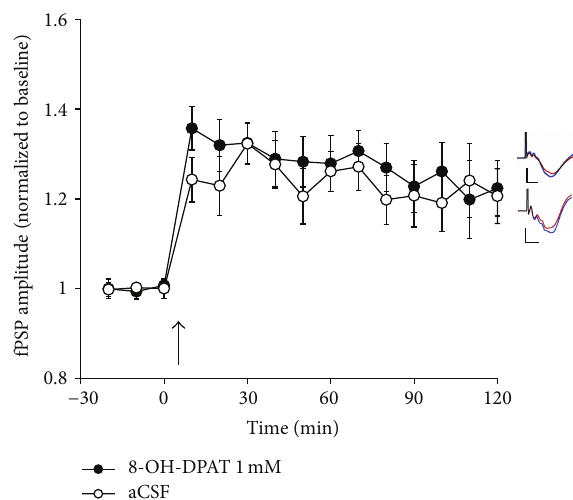
Figure 7: The effect of application (in V1 by means of reverse microdialysis) of either aCSF ( 𝑛 = 7 ) or WAY 100635 (1mM, 𝑛 = 8 ) on LTP following TBS (at arrow) of the LGN in juvenile (mean age 45 days, range 42–48 days), urethane-anesthetized rats. Application of WAY 100635 resulted in a suppression of LTP relative to animals receiving aCSF during four of the last five 10 min recording epochs relativetoanimalsreceivingaCSF.InsertsdepicttypicalfPSPsbefore (red) and after (blue) LTP induction in the presence of aCSF (top) and WAY 100635 (bottom; calibration bars indicate 0.5 mV vertical and 10 ms horizontal; each fPSP trace is an average of 30 min of continuous recording). ∗ indicates a significant ( 𝑃 < 0.05 , 𝑡 -test) difference between the two